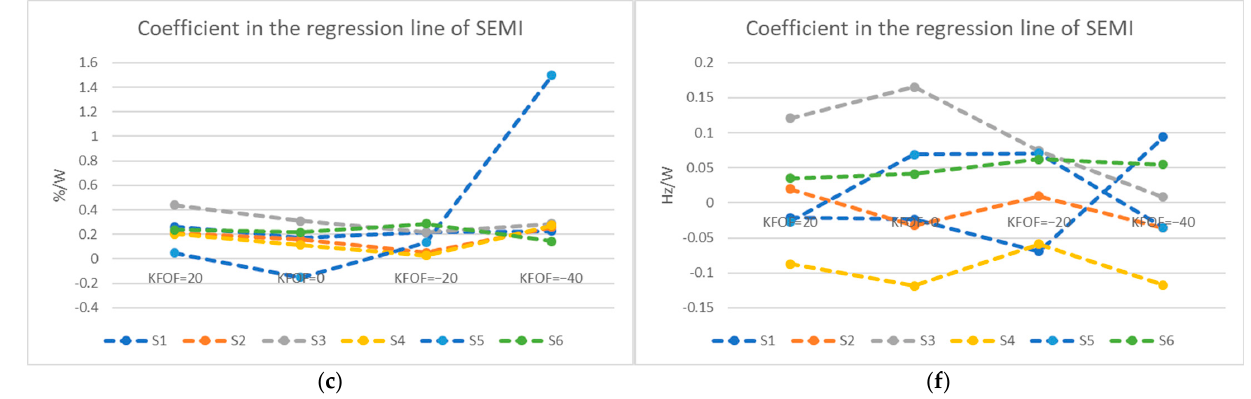
Figure 3. ( Left ) Coefficient in the regression line of the RMS value in GXT for ( a ) Vastus lateralis (VL); ( b ) Vastus medialis (VM); ( c ) semitendinosus (SEMI); ( Right ) Coefficient in the regression line of median frequency in GXT for ( d ) Vastus lateralis (VL); ( e ) Vastus medialis (VM); ( f ) semitendinosus (SEMI).